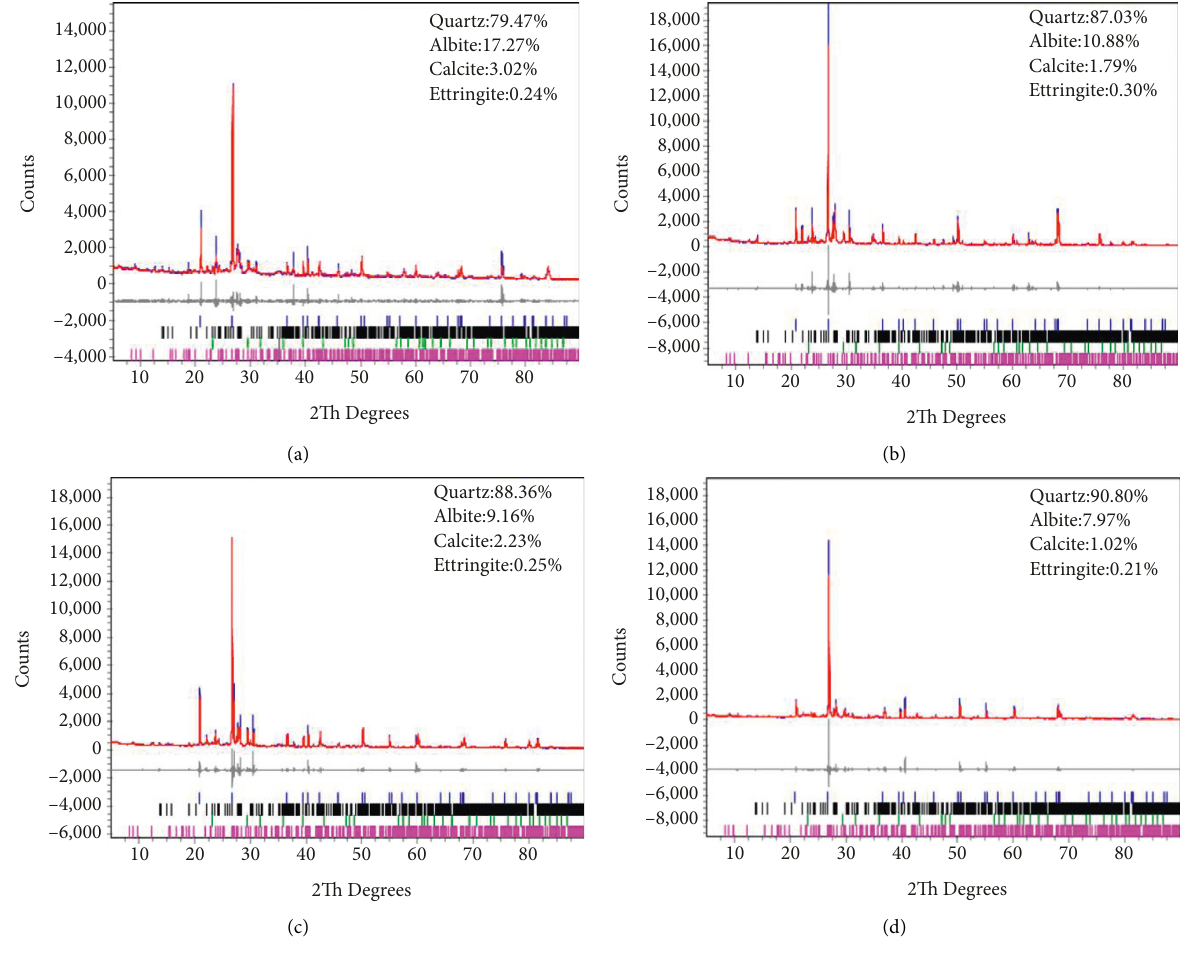
Figure 6: XRD spectra (a) 0% (b) 0.5% (c) 1.0% (d)